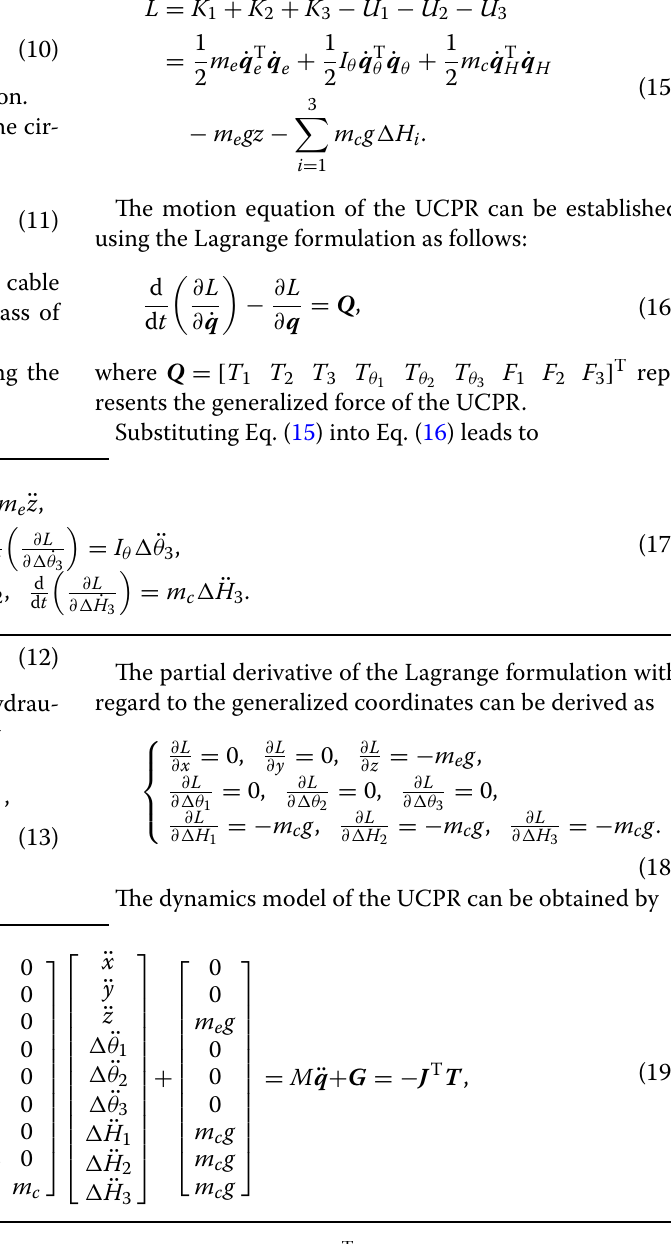
T represents the tension vector of